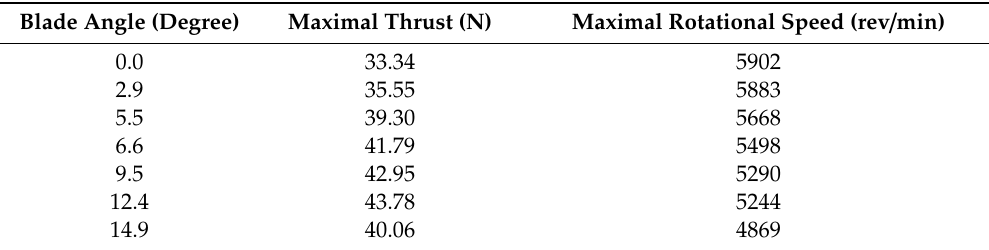
Table 1. Maximal thrust for various pitch angles.